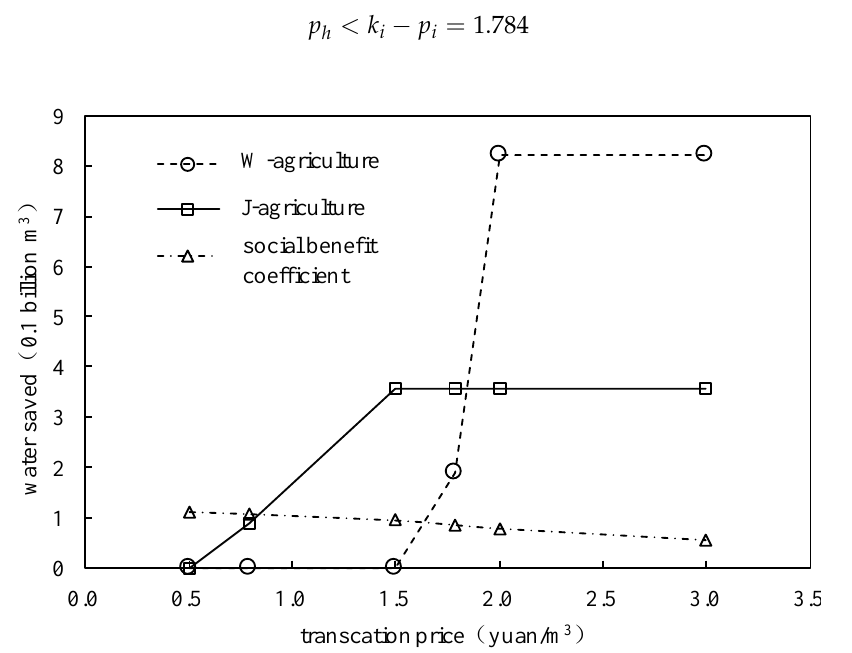
Figure 3. Relationship between water transaction price and water-saving amount of each agent in 2020.